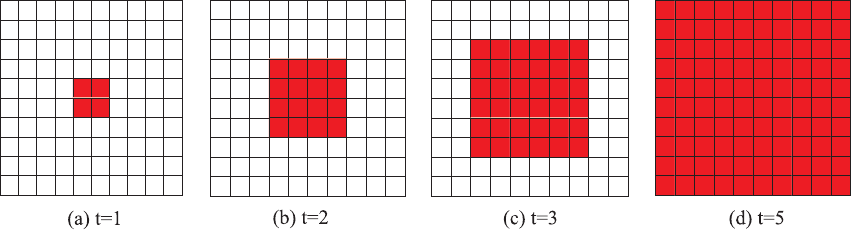
Figure 7. (Color online) Time evolution of cooperator-invasion on a 10 | 10 square lattice with 8-player neighborhood. Initially, there are four cooperators (the four red squares in figure(a)) and ninety-six defectors (the ninety-six blank square in figure (a)). If R v 3 M = 10 , then the cooperators take over the entire population in the stationary state ( t ~ 5 , figure (d)).